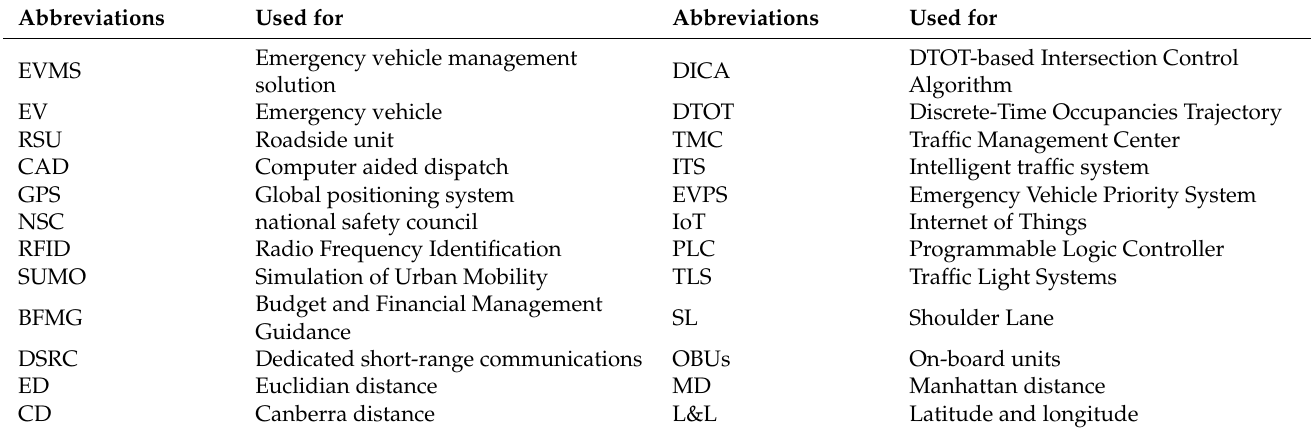
Table 1. List of abbreviations used in this